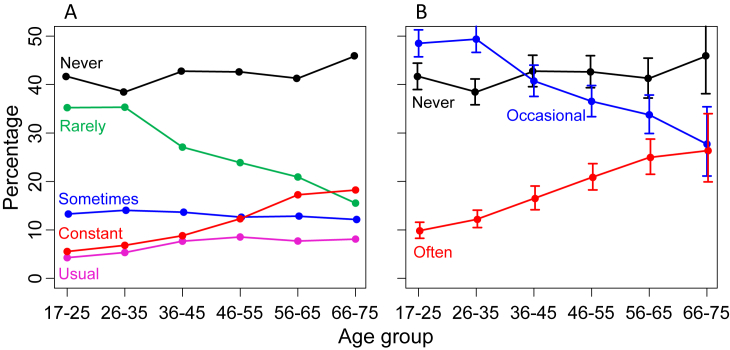
Prevalence of tinnitus by age. A. Percent responses to the 5 options posed in the question about tinnitus. B. Percent responses regrouped to a simpler, 3-option grouping as elaborated in text.